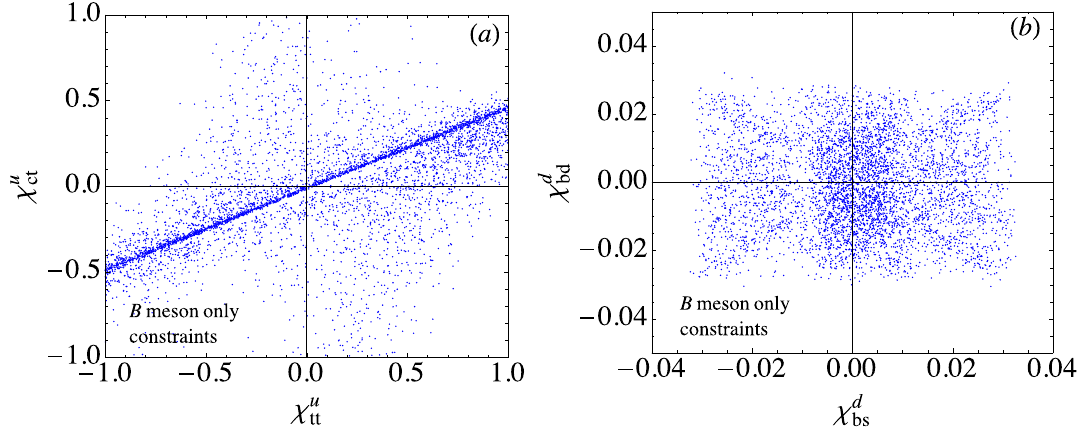
Figure 5 . Constraints from (cid:1) M B allowed ranges of (cid:31) u sample points used for the scan is 5